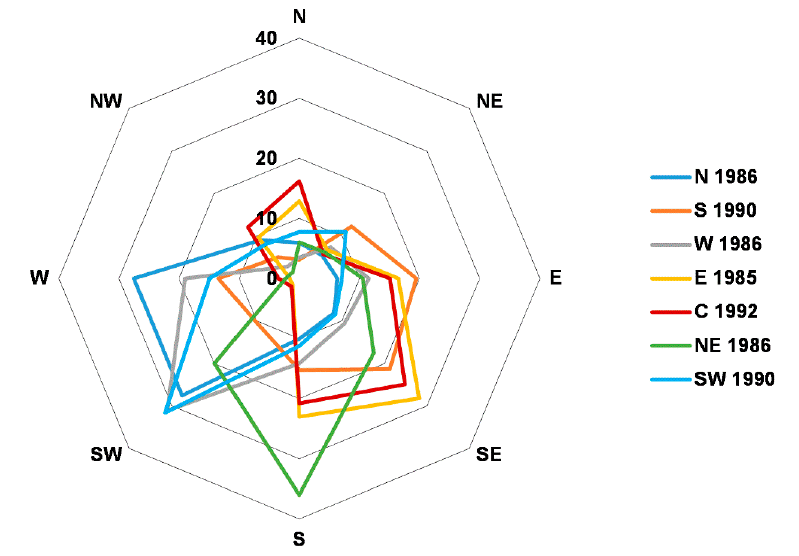
Figure 5. Percentage share of slope exposure for the nunataks visible on images from 1985–1992 in Spitsbergen.